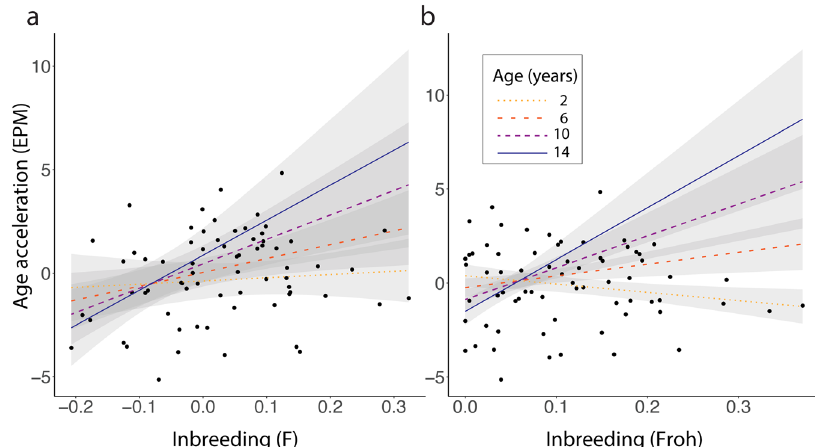
Fig. 2 Relationship between epigenetic age acceleration calculated from the epigenetic pacemaker (EPM) model and inbreeding in plains zebras. Lines represent the predicted age acceleration for individuals with different chronological ages and different levels of inbreeding. Gray areas show 95% con fi dence intervals. Black dots represent the individual plains zebra data. Inbreeding was calculated in PLINK as a F and b F ROH